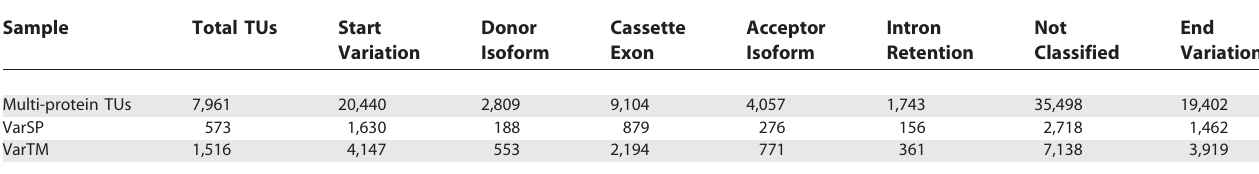
Table 2. Comparison of Events Causing Transcriptional Variation